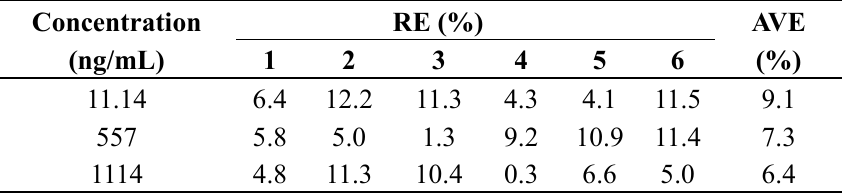
Table 6. Accuracy for the analysis of TA-III ( n = 6).